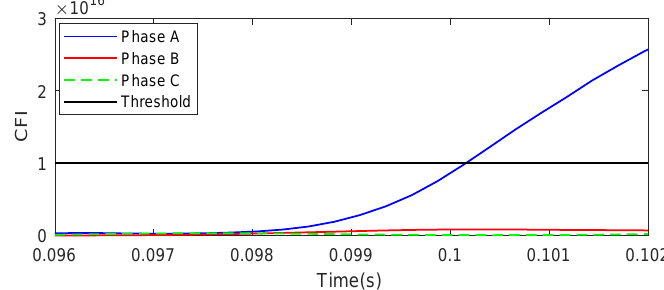
Figure 5. Estimation of time involved during phase A to ground faulty